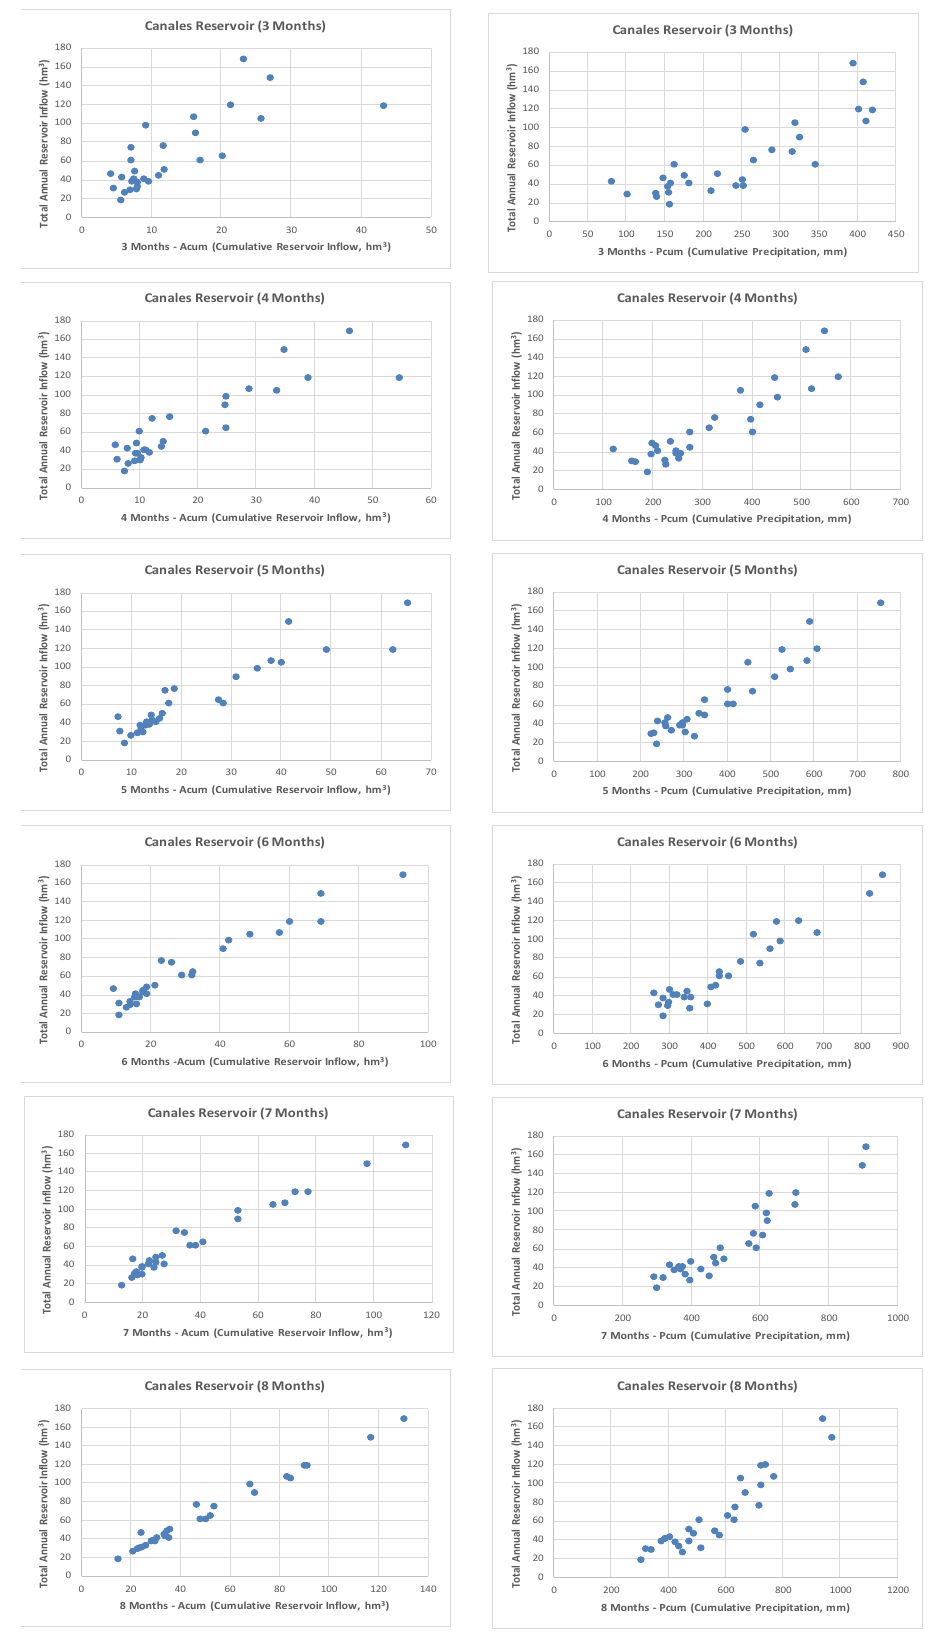
Figure 5 . Canales reservoir: Regression analysis for the first three, four, five, six, seven, and eight months using the cumulative monthly reservoir inflow and precipitation.